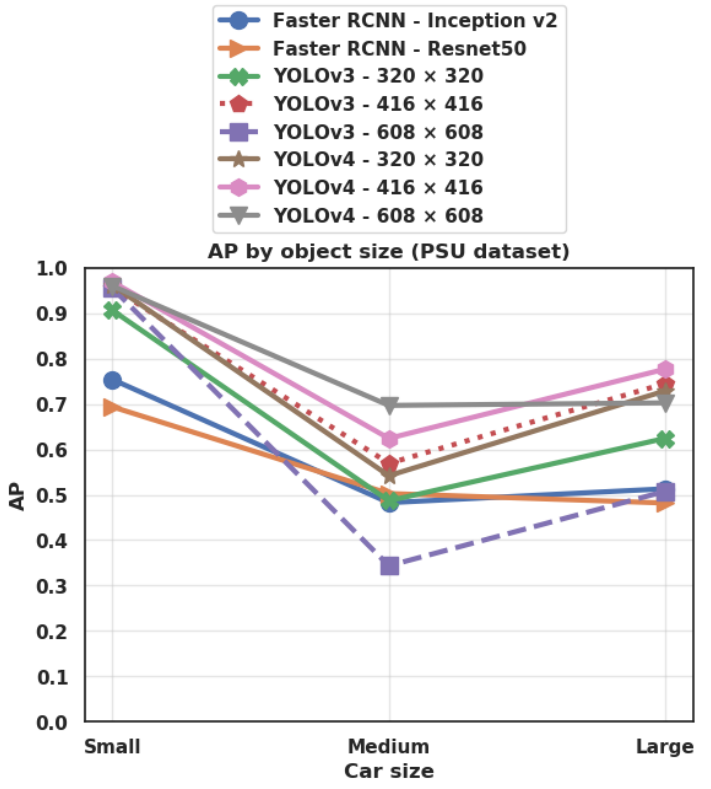
Figure 15. Average Precision (AP) for each category of object size: small (object surface < 5000 pixel 2 ), medium-size (5000 pixel 2 ≤ object surface ≤ 10,000 pixel 2 ), and large (object surface > 10,000 pixel 2 ), on the PSU (Prince Sultan University)